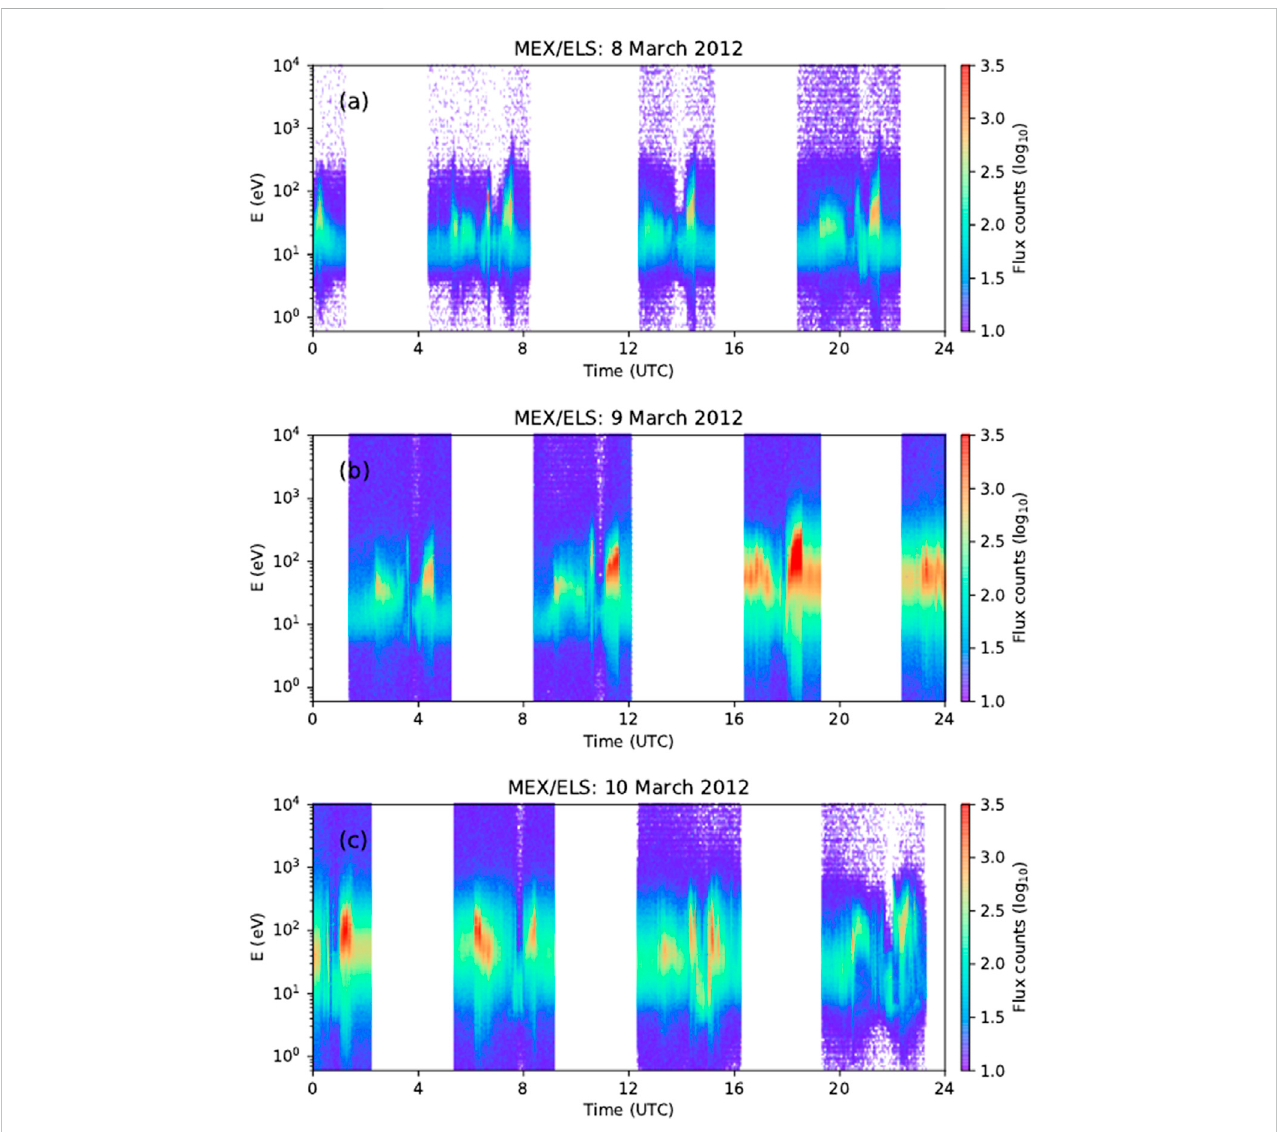
FIGURE 9 ELS spectrogram for MEX from 8 March 2012 to 10 March 2012 (A – C)